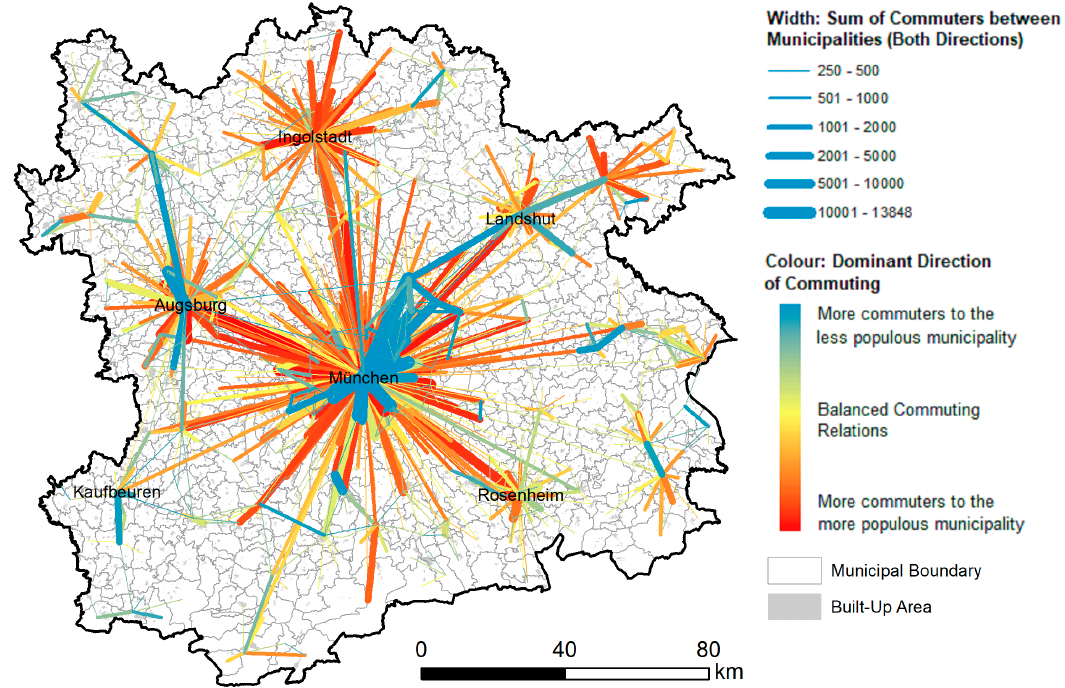
Figure 2. Strongest commuting relations in the MMR in 2018 (Source: own work, using geodata by Bayerische Vermessungsverwaltung, Bundesamt für Kartographie und Geodäsie, Bundesagentur für Arbeit).